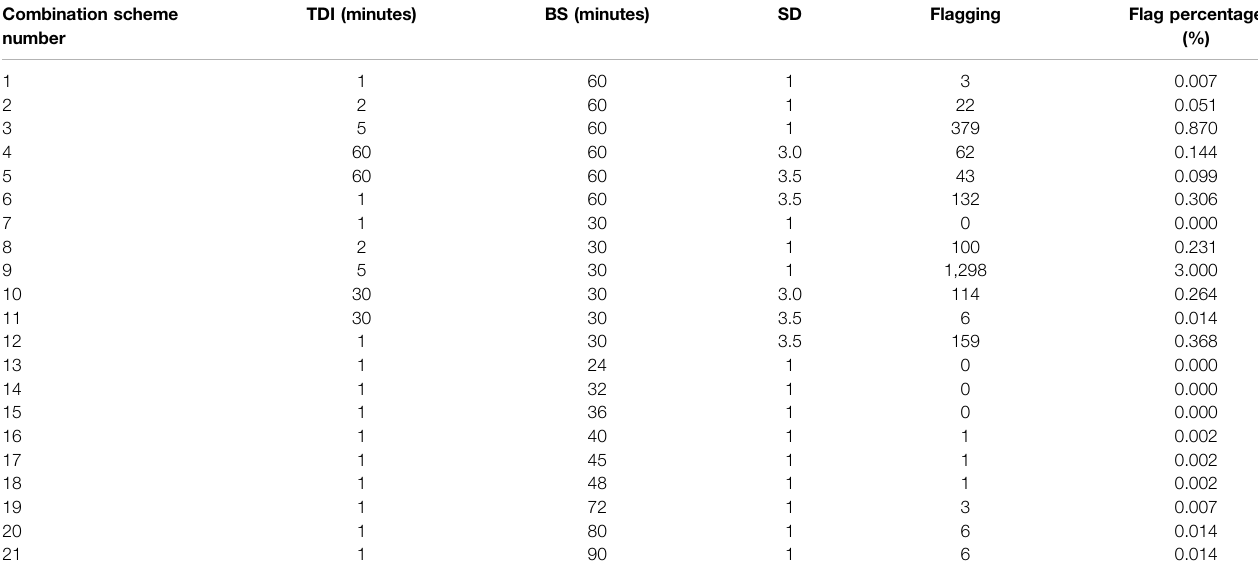
TABLE 2 | The results of threshold tests at different bins and time displacement for raw temperature data at SA on 29 April 2016, in which TDI is for a time displacement interval (minutes), BS is for a bin size (minutes), and SD is for standard deviation. Combination scheme